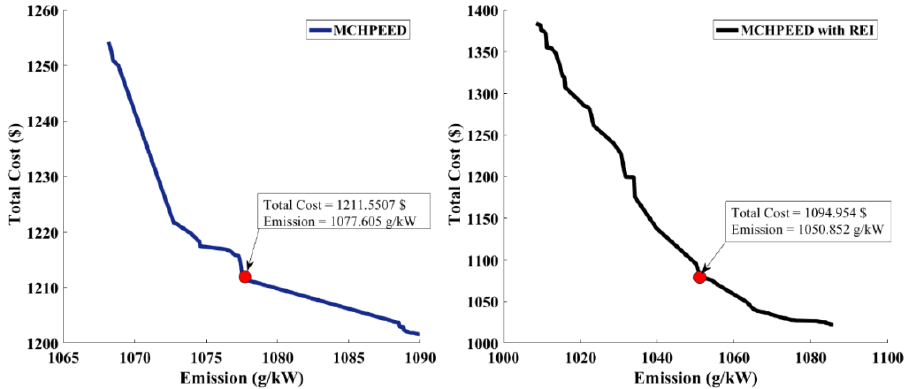
Figure 9. Pareto optimal fronts for MCHPEED and MCHPEED with REI.